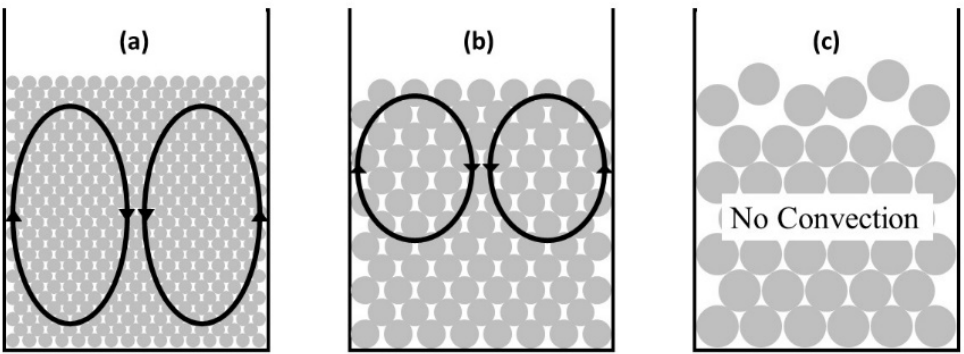
Figure 5. Convection type as a function of ball size of medium: ( a ) 1, ( b ) 2, and ( c ) 3 mm.